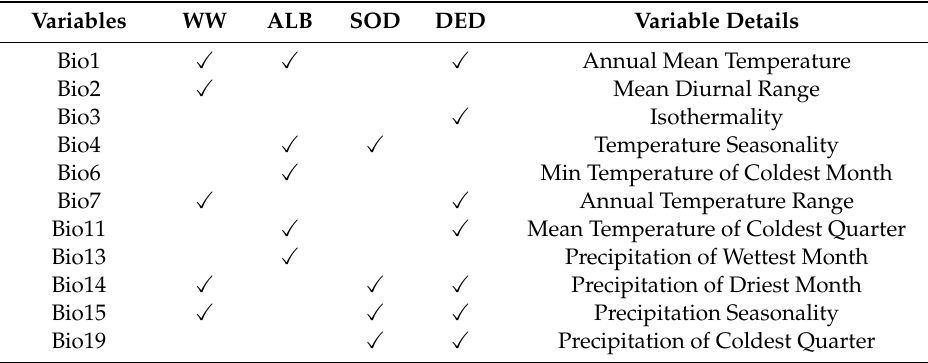
Table 1. Climatic variables for niche analyses of selected forest invasives selected using the R package “Maxent Variable Selection” [42].